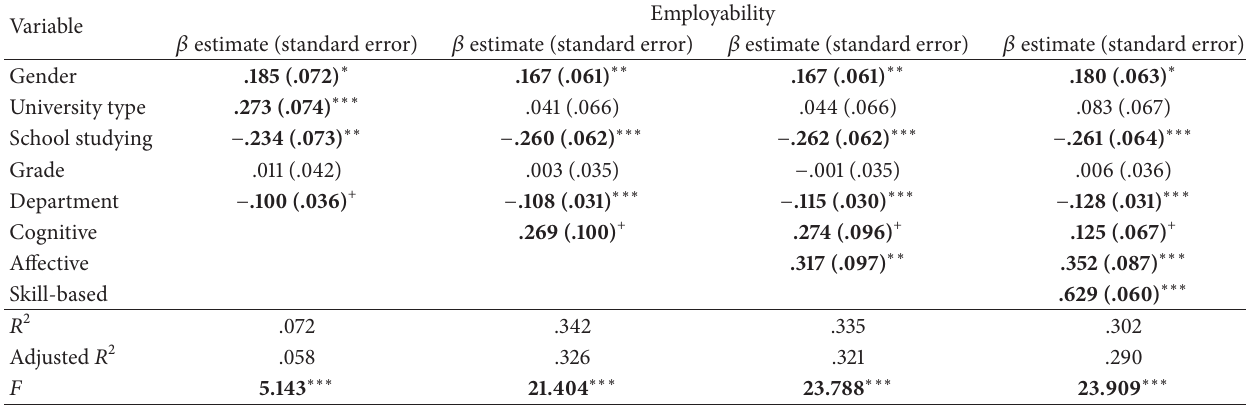
Table 8: Multiple regression analysis—three-domain curriculum on employability (university